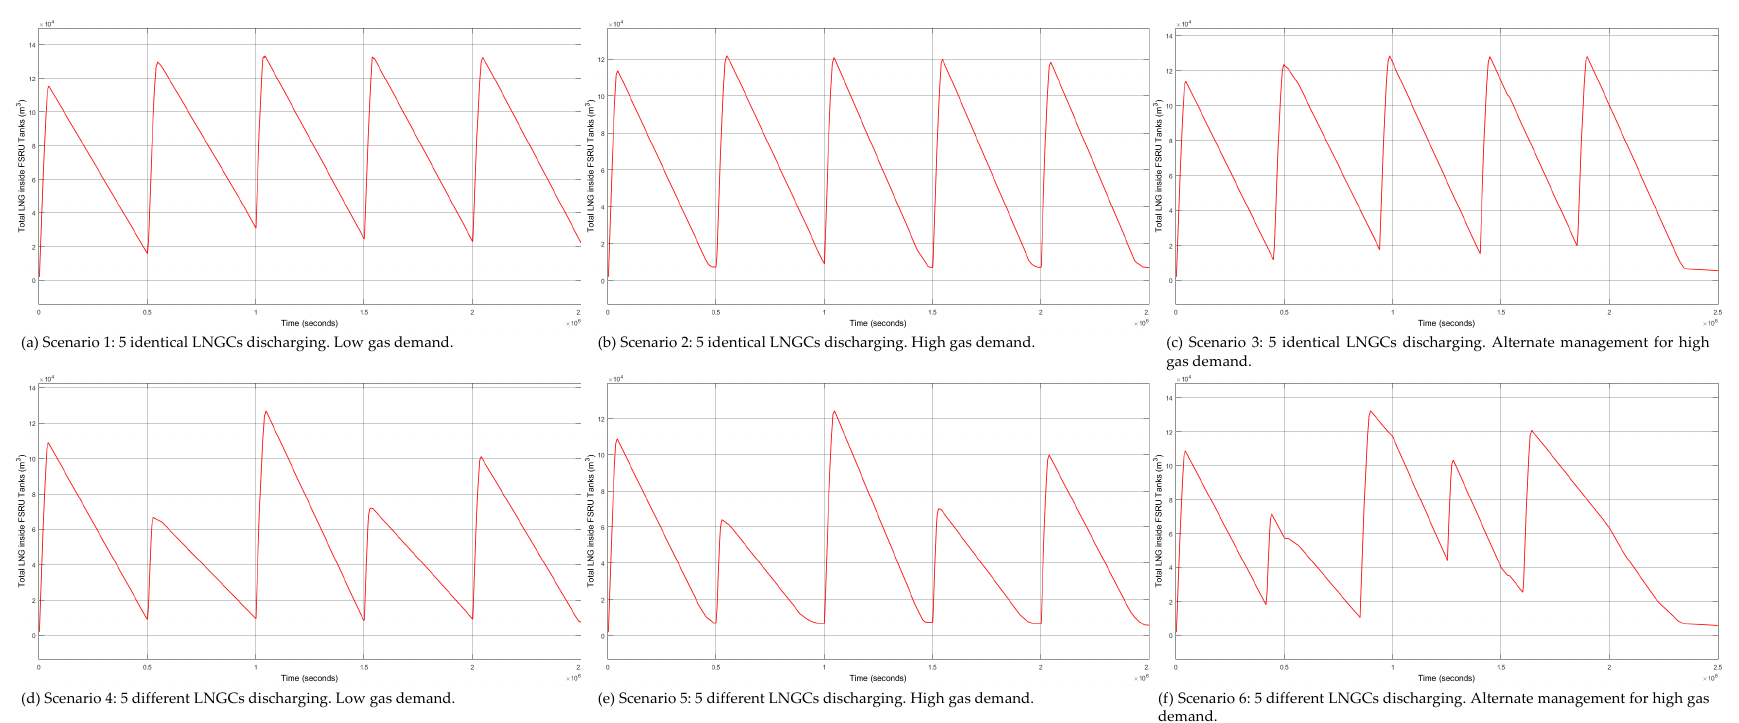
Figure 9. LNG inventory held in the FSRU for di ff erent operation